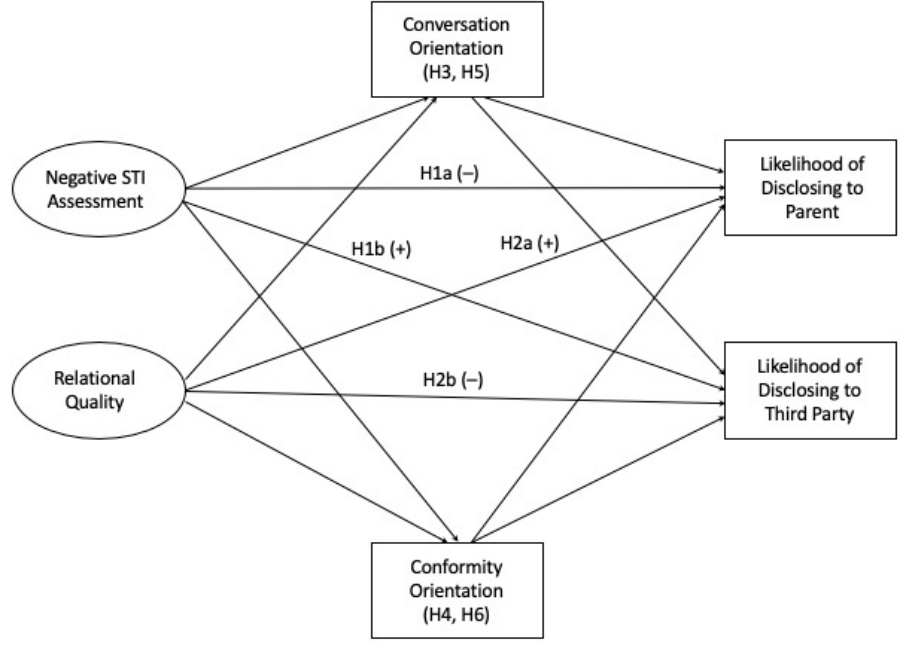
Figure 1. Hypothesized model.